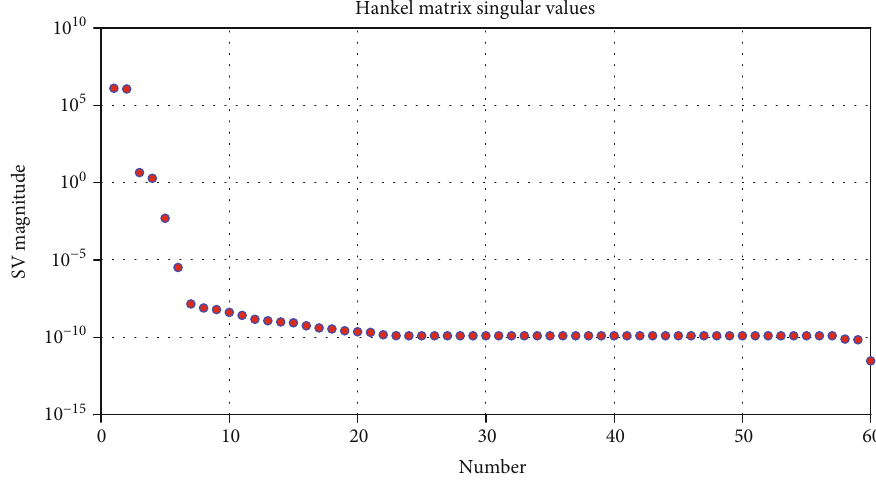
Figure 7: Singular values magnitude of the system by the OKID method.